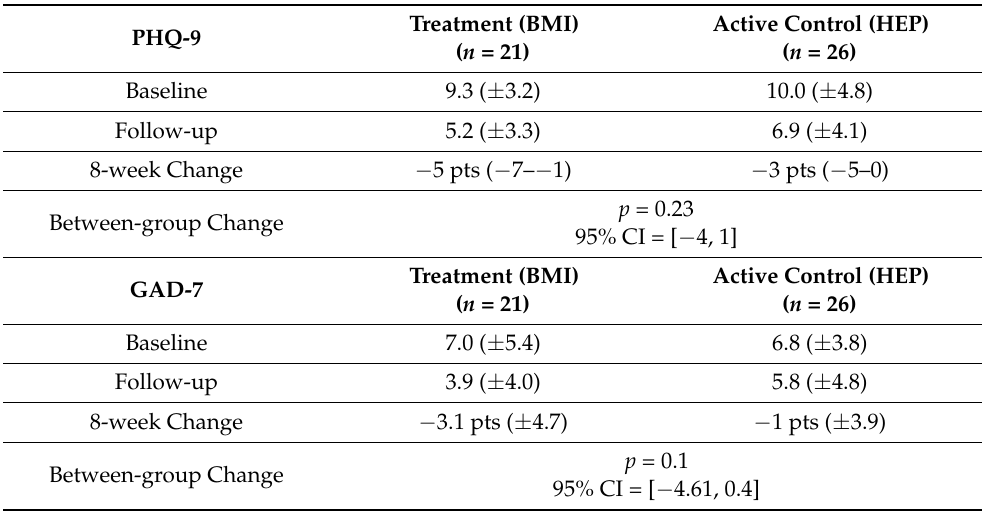
Table 3. Secondary analyses of primary and secondary outcomes: change in depression (PHQ-9) and anxiety (GAD-7) from baseline to 8 weeks ( n =